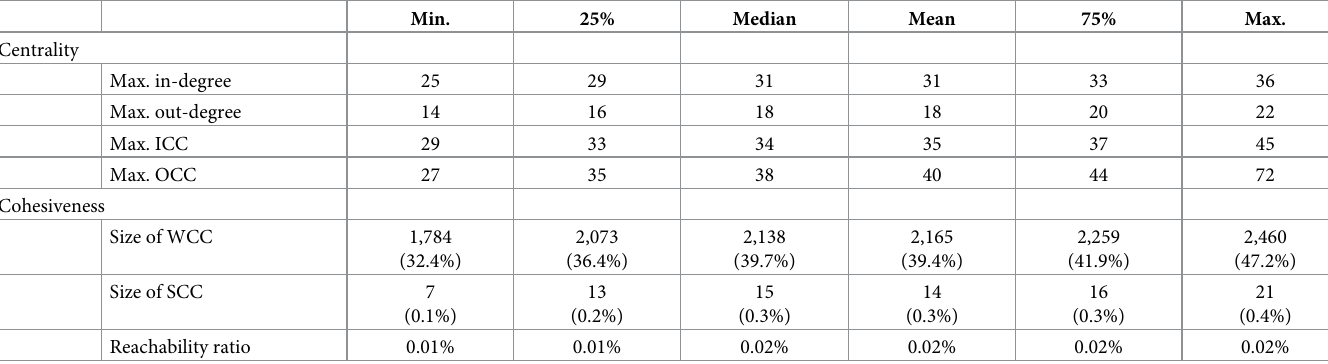
Table 3. Results for centrality and cohesiveness measures over all 48 monthly networks. The networks are based on the animal movement database (AMD). Min. 25%